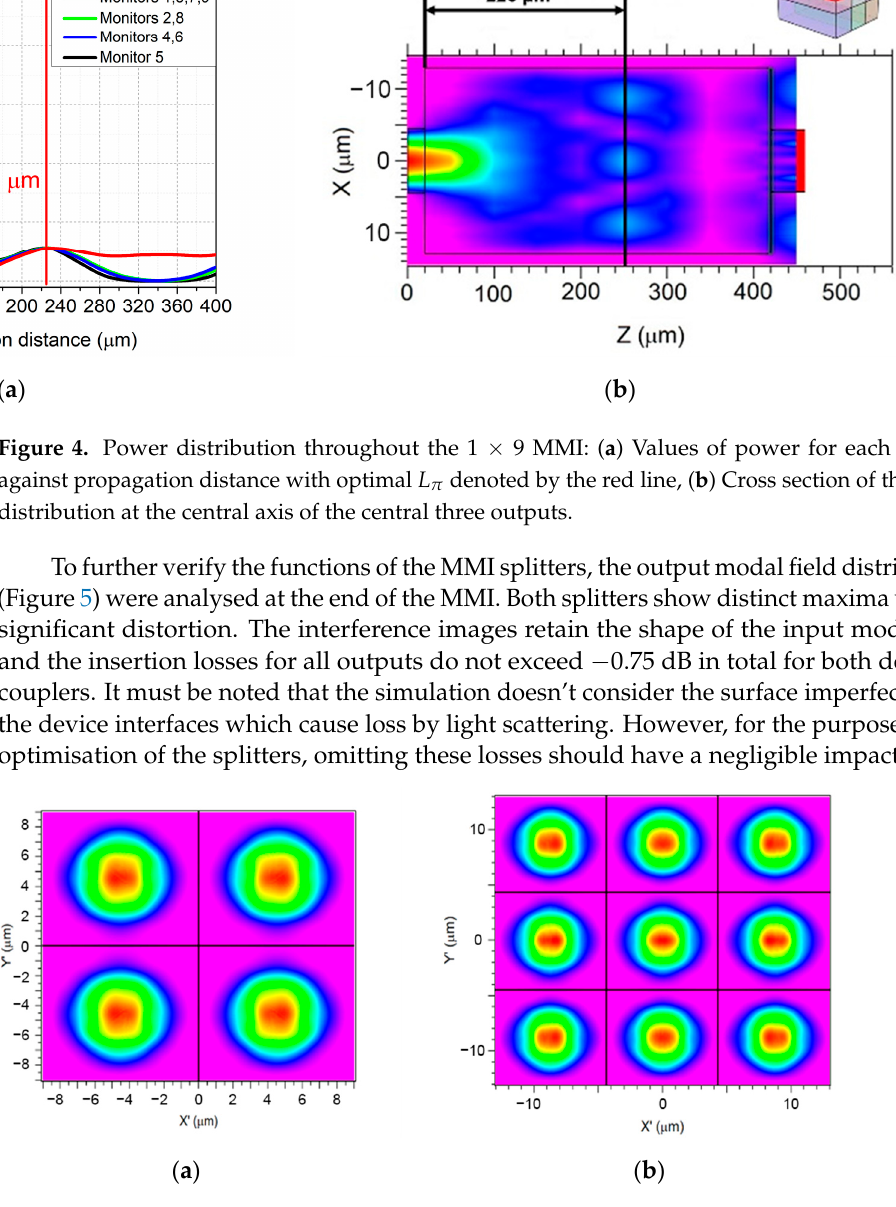
Figure 3. Power distribution throughout the 1 × 4 MMI: ( a ) Values of power for each monitor against propagation distance with optimal L π denoted by the red line; ( b ) Cross section of the power distri- bution at the central axis of the bottom two outputs.